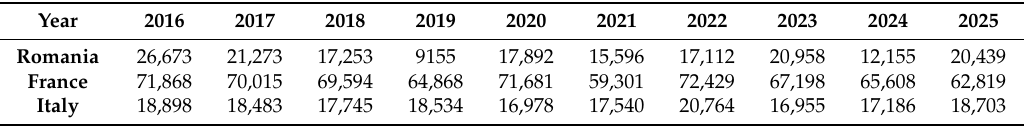
Table 2. Estimated cereals production for the forecasted period (thousand tons). Source: authors’ own calculation based on National Statistics Institute database and [56].